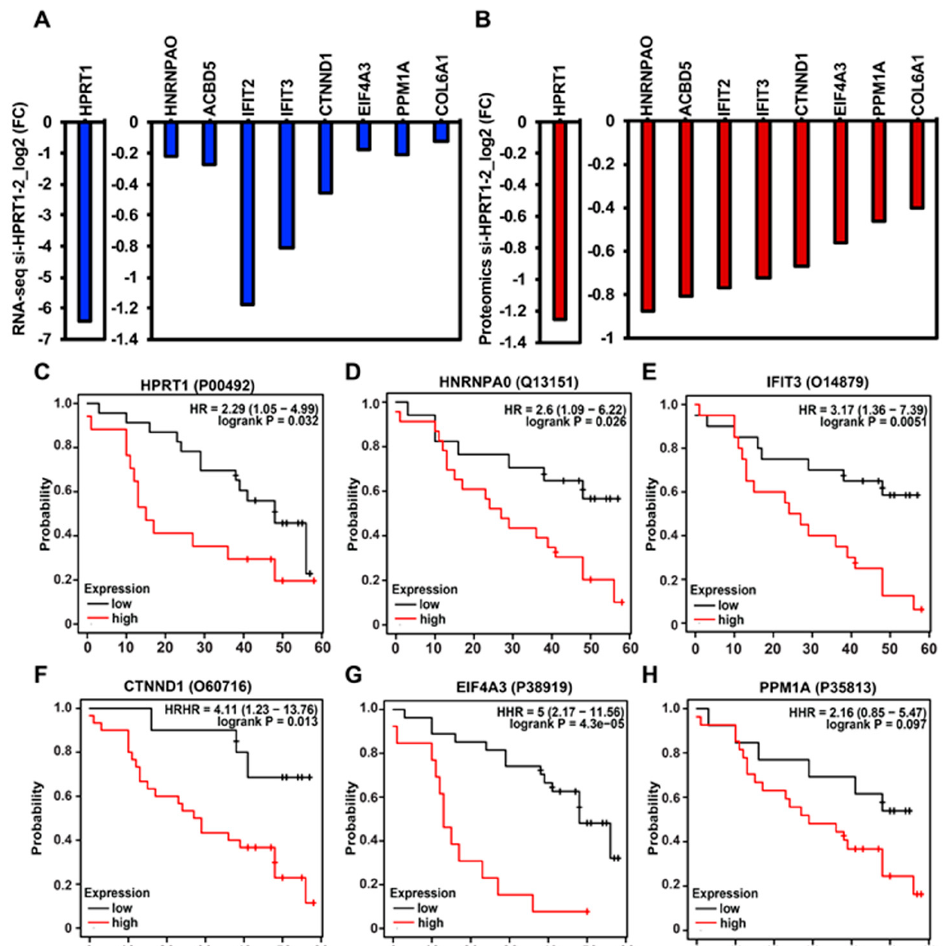
Figure 5. Tandem mass tag-mediated quantification of HPRT1 -downregulated proteins, and their clinical value. ( A ) Expression of HPRT1 -downregulated genes, as assessed by RNA-seq upon HPRT1 knockdown using si-HPRT1-2 in MDAMB231 cells that overlapped with the HPRT1 -downregulated proteins identified by mass spectrometric analysis. ( B ) Expression of the top 10 overlapping (RNA-seq and mass-spec, combined analysis) downregulated genes upon HPRT1 knockdown using si-HPRT1-2 in MDAMB231 cells. ( C ) Kaplan–Meier analysis (overall survival) of HPRT1 protein abundance showed poor clinical outcome in breast cancer patients. ( C – H ) Kaplan–Meier analysis (overall survival)